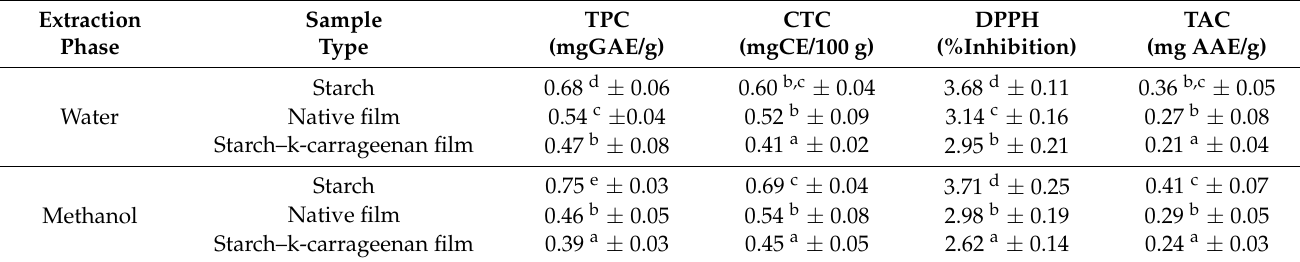
Table 1. Antioxidant and bioactive compounds in the proso millet starch and films. Extraction